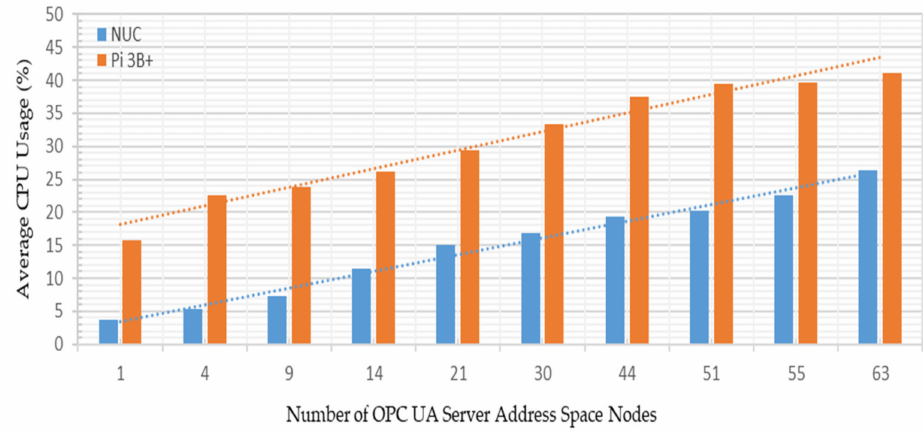
Figure 20. Average percentage of platform CPU utilized by the developed system with varying the OPC UA server address space variable nodes.